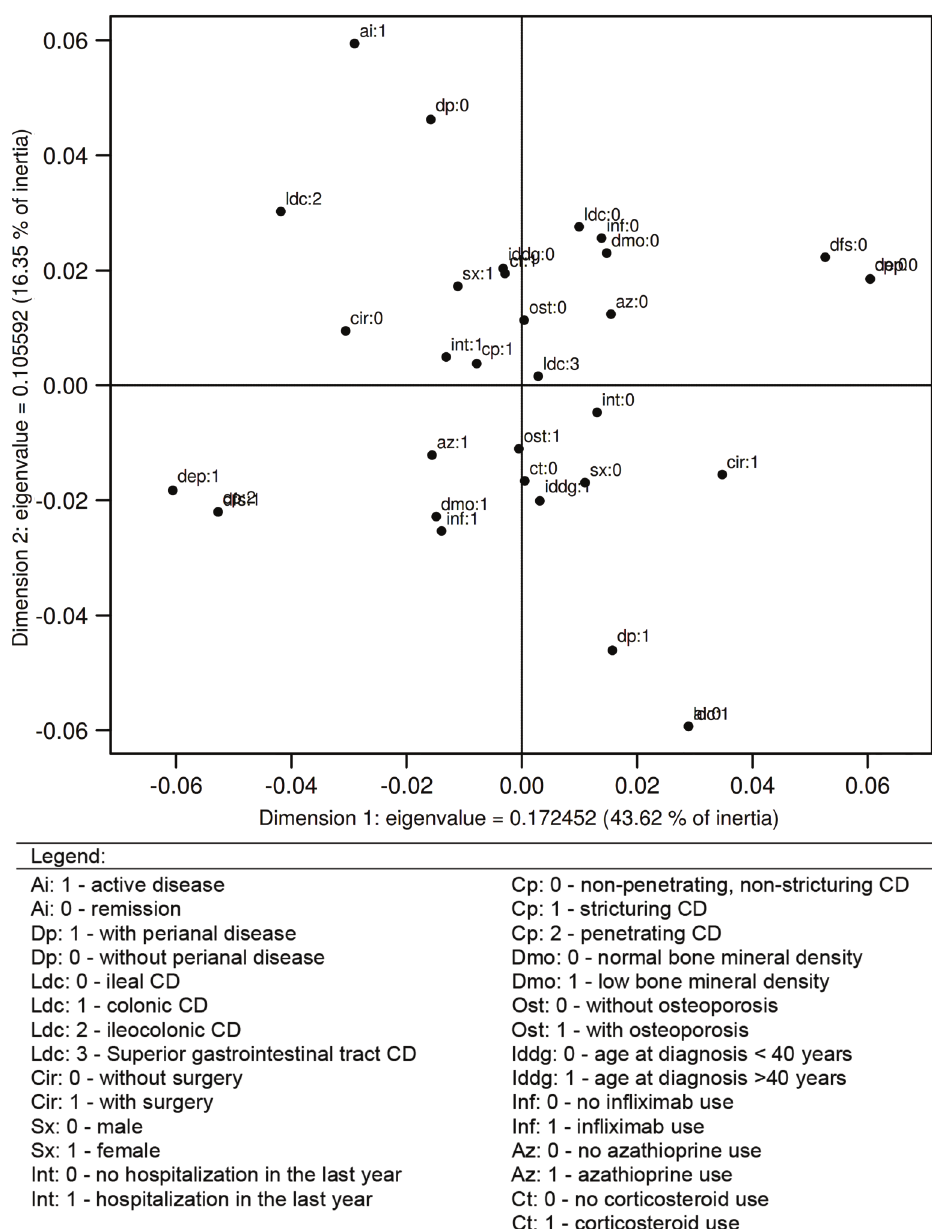
Figure 1. Multiple correspondence analyses for categorical variables in Crohn ’ s disease (CD)